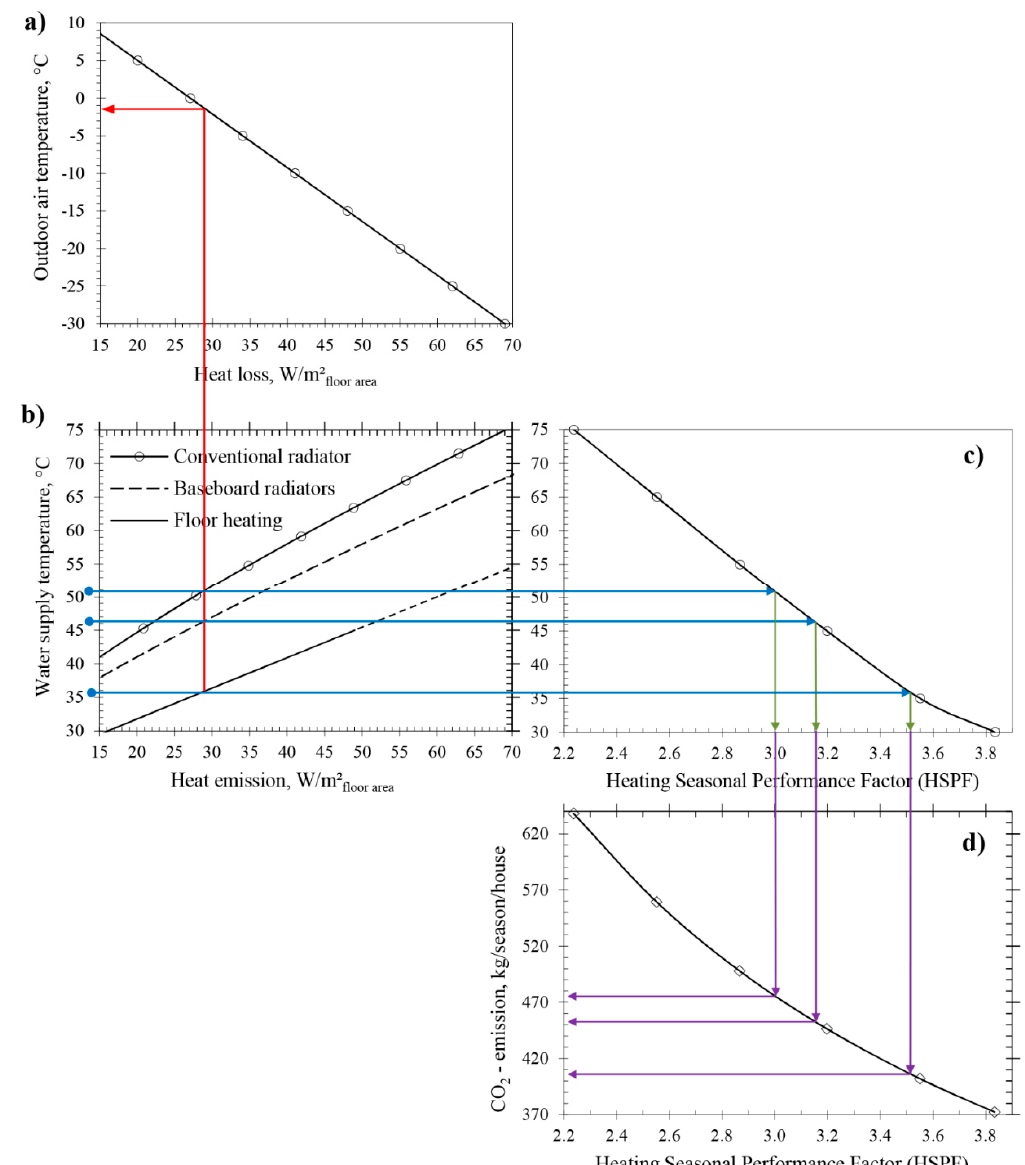
Figure 4. ( a ) Variation of heat loss versus outdoor temperature for a Scandinavian single-family dwelling built before 2000. Room floor area = 20 m 2 . ( b ) The required supply water temperatures for conventional and baseboard radiators and floor heating to cover heat loss from the considered dwelling. ( c ) The variation of HSPF with supply water temperature for a 6.4 kW GSHP installed in the considered dwelling. ( d ) The variation of CO 2 emissions as a function of HSPF for the used dwelling.